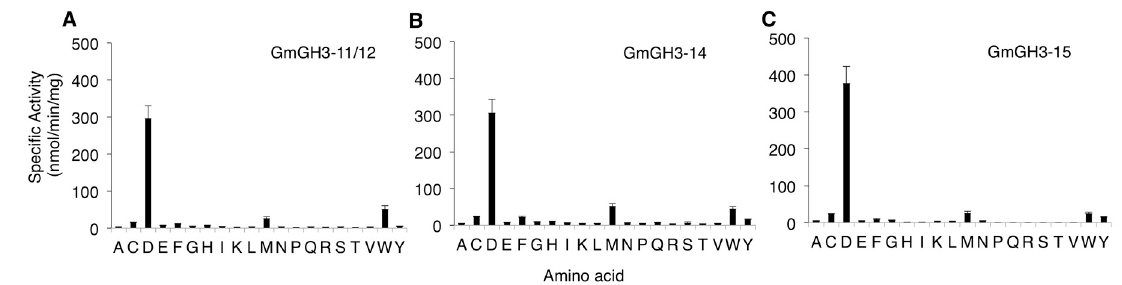
Figure 2. Amino acid substrate preference of nodule enriched GmGH3s. Specific activities of ( A ) GmGH3-11/12; ( B ) GmGH3-14, and ( C ) GmGH3-15 with IAA as acyl substrate with each of the 20 different amino acids denoted by single letter IUPAC codes. Data shown are the average specific activities from three replicate assays and error bars indicate SD.